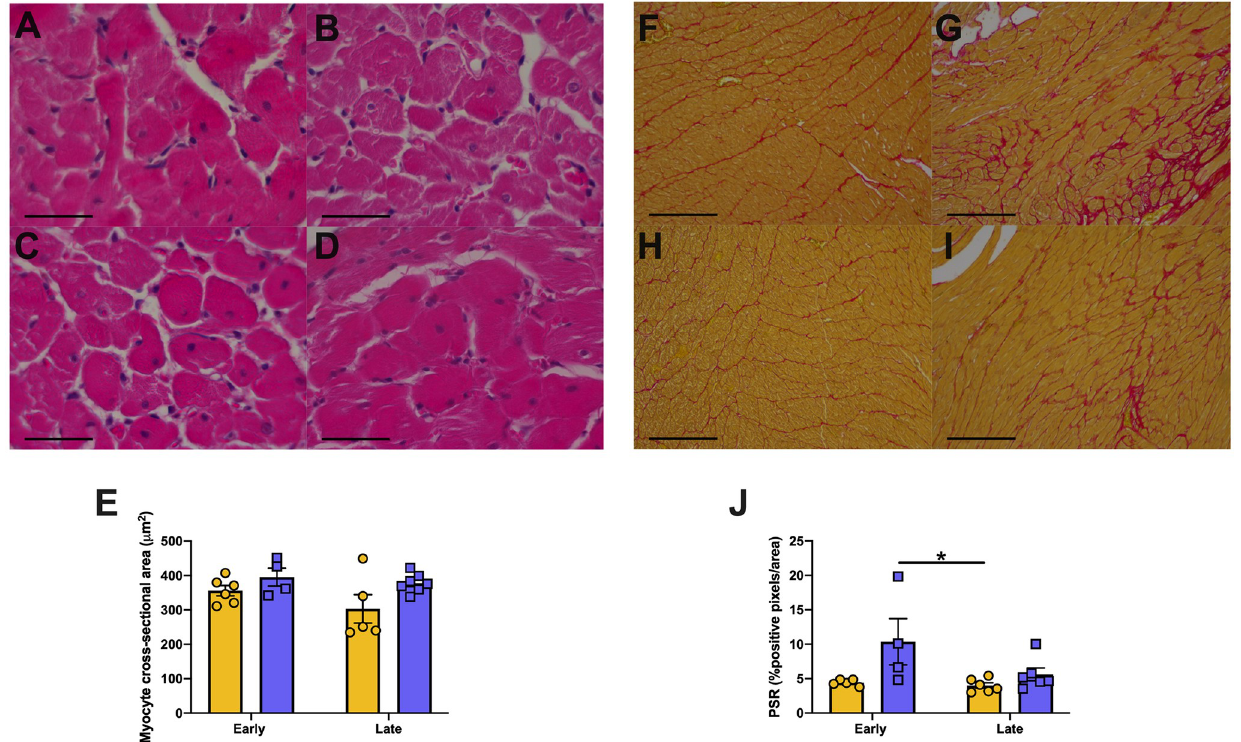
Fig 2. Cardiac Structure in Wistar and GK rats over time. Representative hematoxylin and eosin-stained sections and PicroSirius red stained sections. Where hearts of Wistar (A,C,F,H) rats and Goto Kakizaki (B,D,G,I) rats at early(28 weeks; A,B,F,G) and late (48 weeks; C,D,H,I) time points had myocyte hypertrophy (E) and fibrosis (J, positive PSR stained pixels) measured. � = p < 0.05 when comparing groups; A Two-Way ANOVA with multiple comparisons Holm-Sidak test used to compare groups. Yellow = Wistar and Blue = GK Data is expressed as mean ± SEM N = 4–8 per group. Scale bars (A-D) 50 μ m and (F-I) 200 μ m.